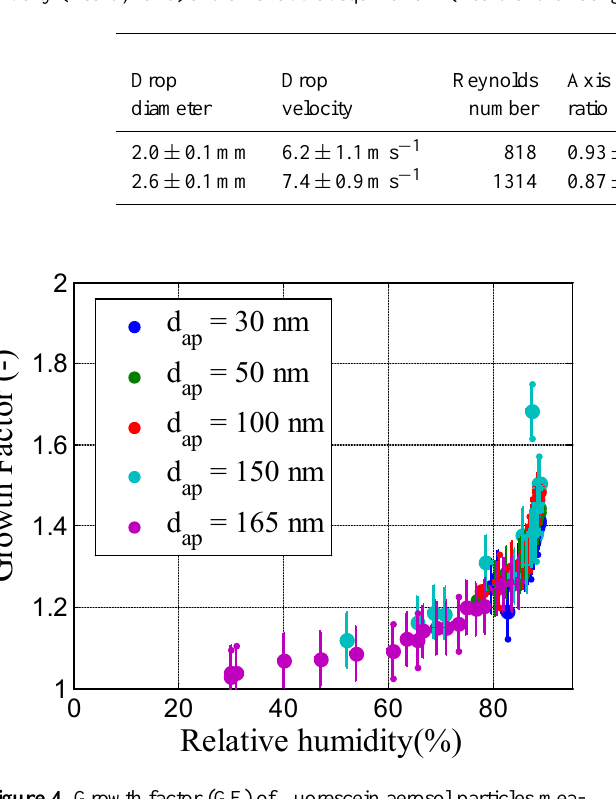
Table 1. Comparison between drop velocities and axis ratios measured in the BERGAME aerosol chamber with models to determine drop velocity (Beard, 1976) and axis ratio at equilibrium (Beard and Chuang, 1987).